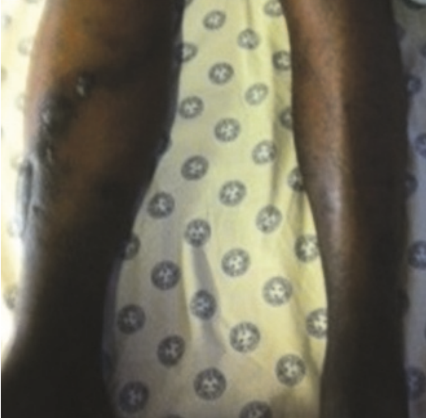
Figure 1: The right lower limb was noted to be larger than the left lower limb on arrival to the Emergency Department.